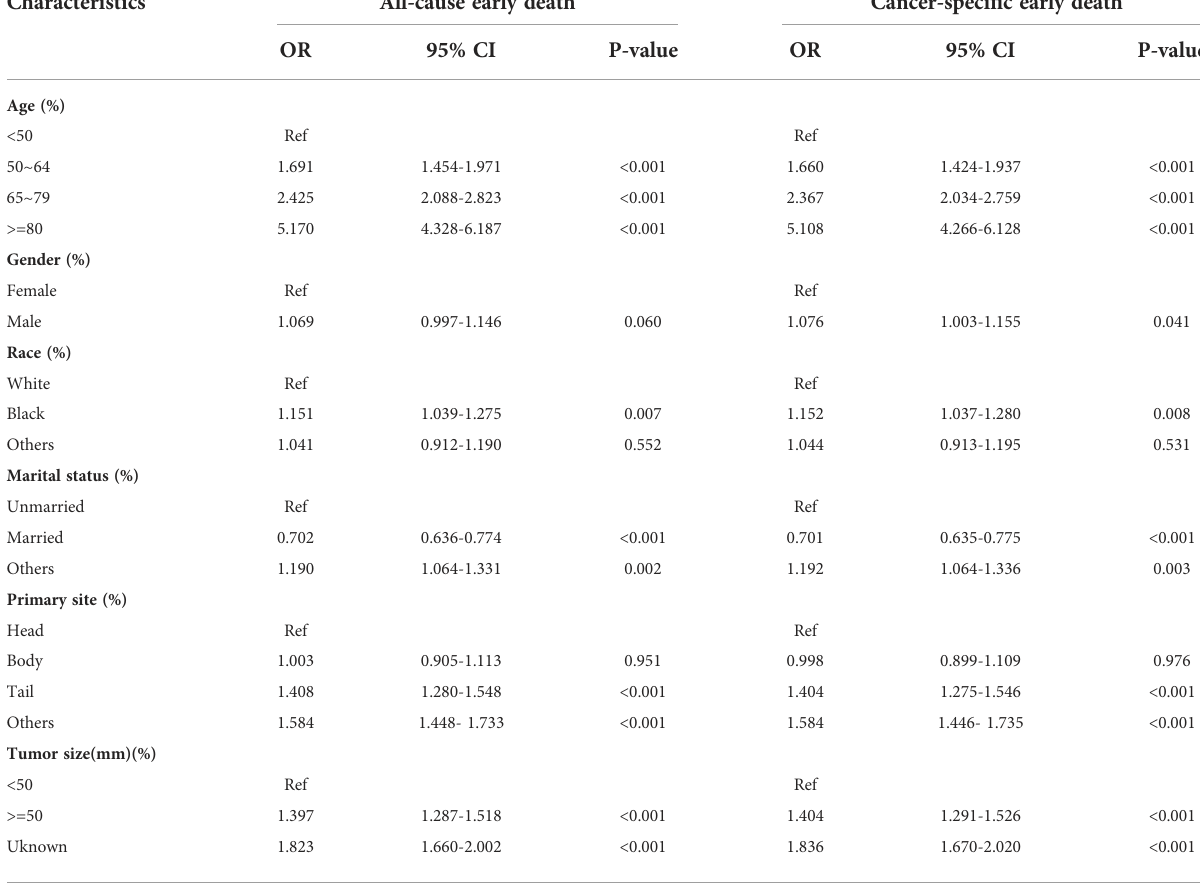
TABLE 3 The univariable logistic regression analysis of all-cause and cancer-speci fi c early death in PCLM patients.